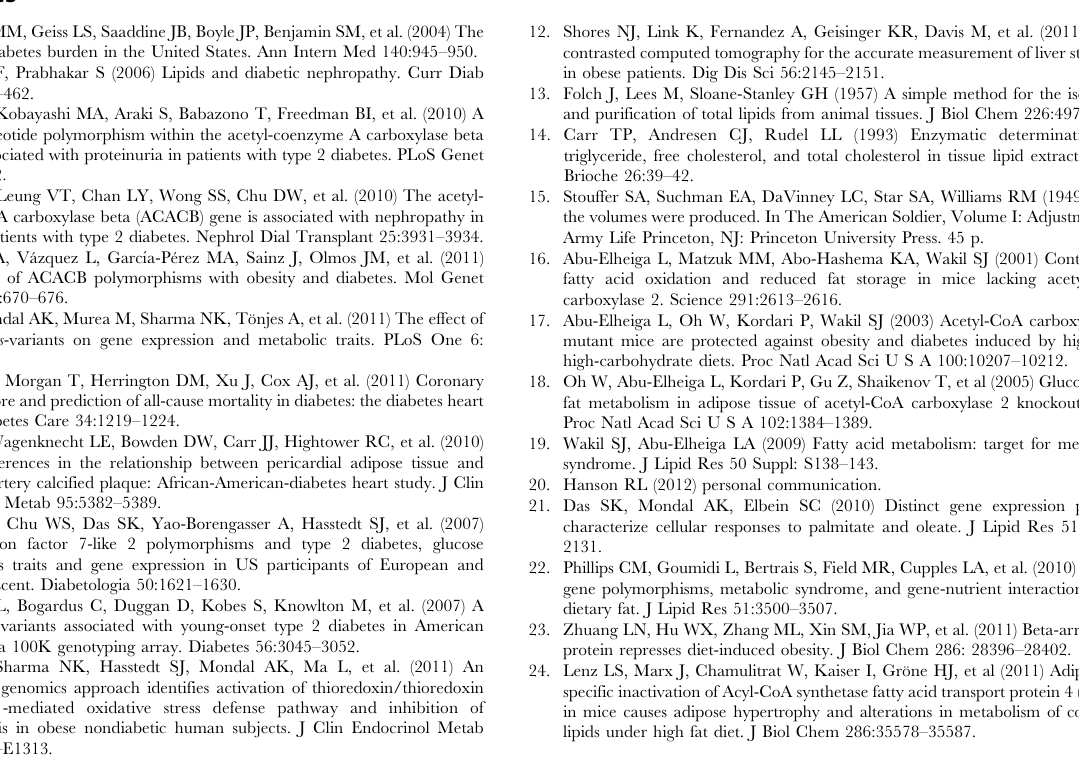
Figure S4 Liver ACACB protein level (an example gel image for Western Blot) in Caucasians (underwent bariatric surgery: BMI . 30 kg/m 2 ). (JPG) Table S1 Association of rs2268388(C/T) with BMI in full- heritage Pima Indian men and